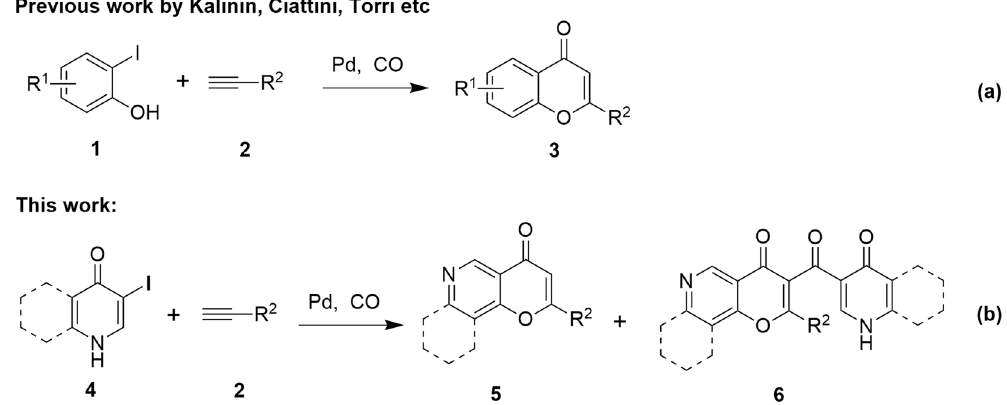
Figure 3. Cascade carbonylative Sonogashira-cyclization of o-iodophenol or 3-iodo-4-(1 H